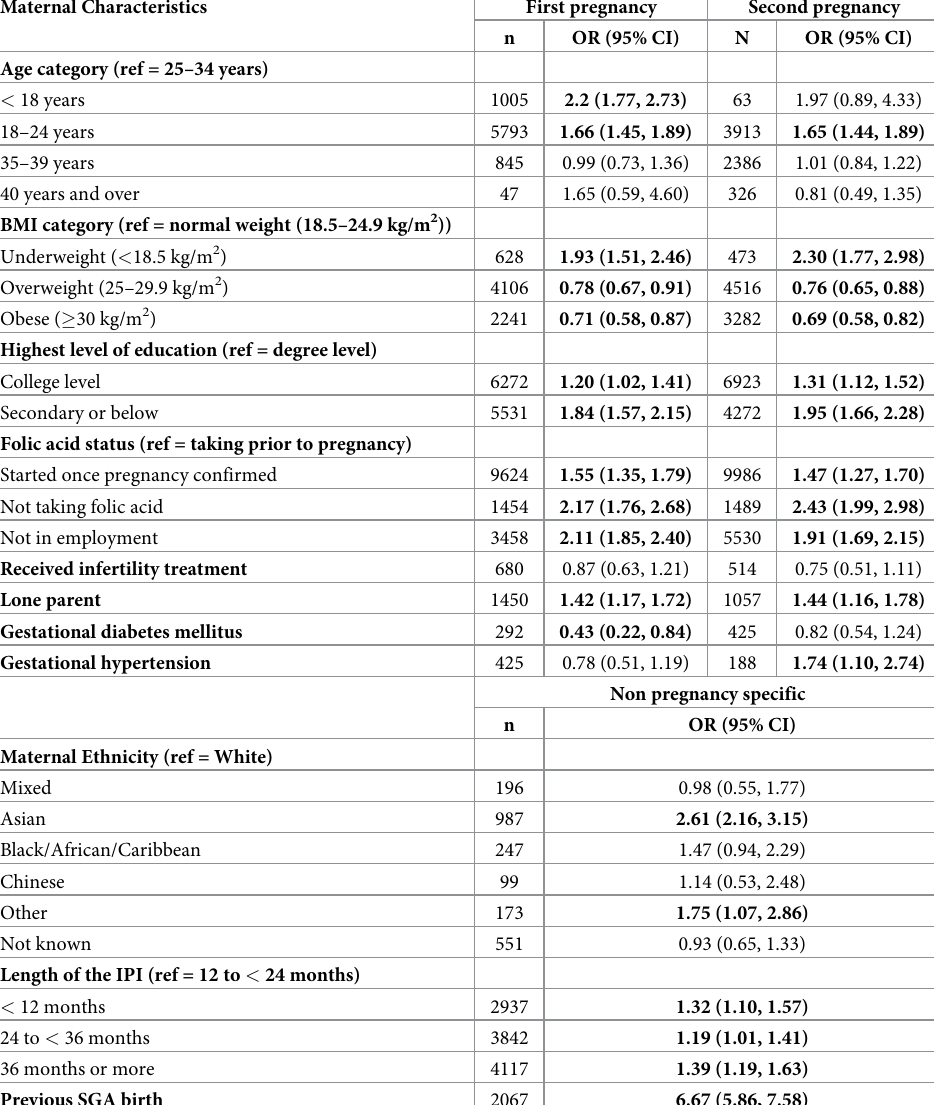
Table 3. Univariate odds of small for gestational age birth ( < 10 th percentile) in the second pregnancy in the full sample, by maternal characteristics recorded at the start of or during the first and second pregnancies. Maternal